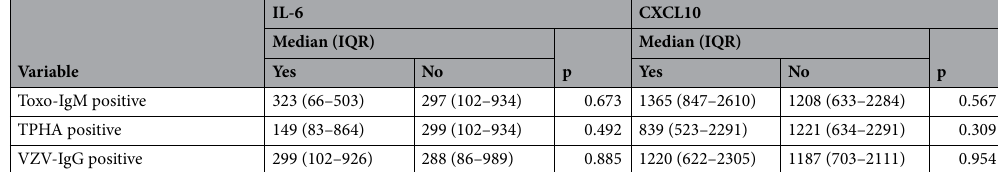
Table 1. Baseline donor characteristics and circulating levels of IL-6 and CXCL10. a Spearman’s Rank correlation coefficient. Bold values indicate Statistically significant.